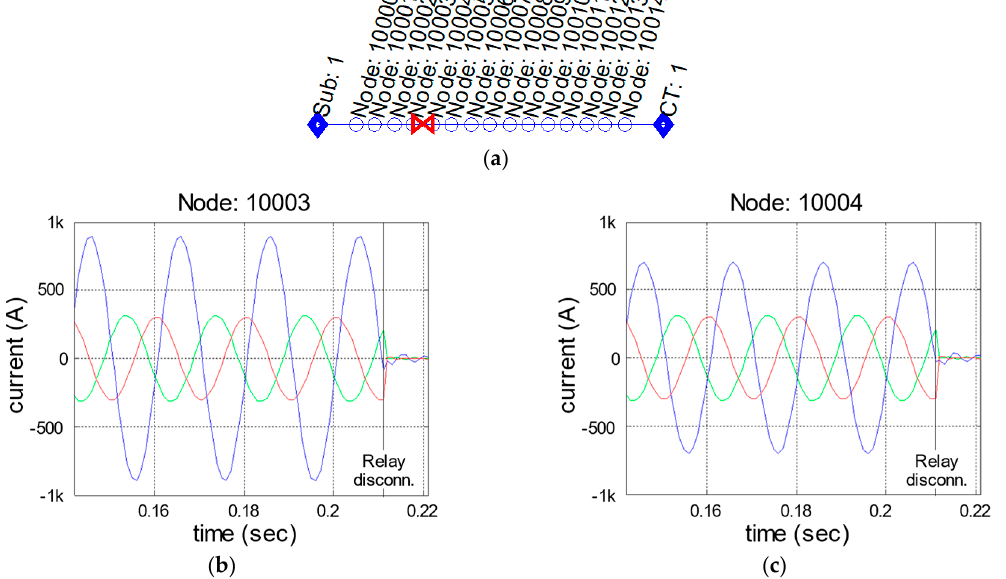
Figure 16. Example of a Fault situation: ( a ) Nodes’ topology; ( b ) data registered by nodes 10003 (at left of the fault position); and ( c ) data registered by nodes 10004 (at right of the fault position).